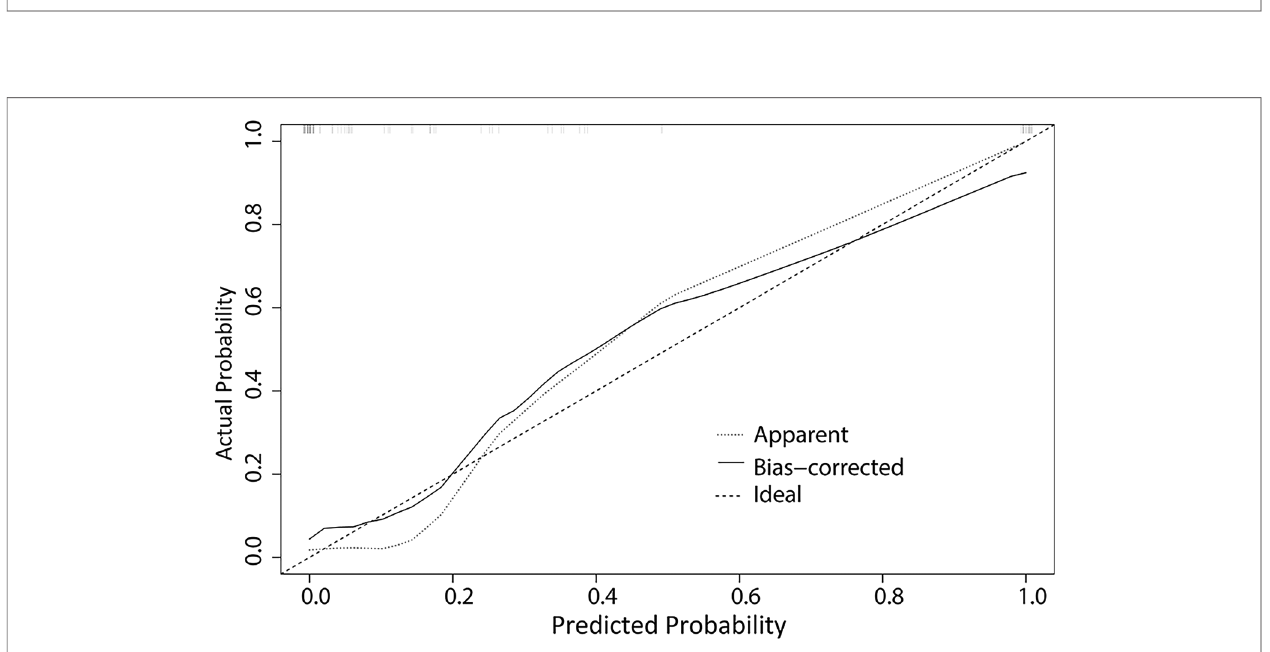
FIGURE 3 | The 1000-bootstrap resampling internal veri fi cation curve for the nomogram of pathologic complete response after neoadjuvant chemotherapy in breast cancer patients.